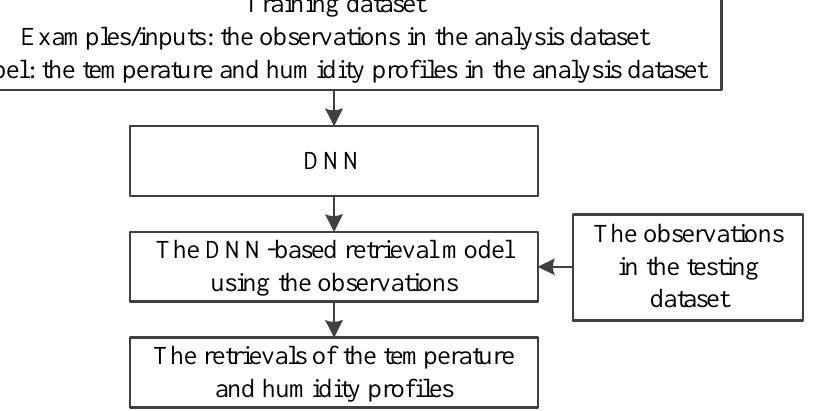
Figure 3. The schematic of the retrieval based on the DNN-based retrieval model using the observations.